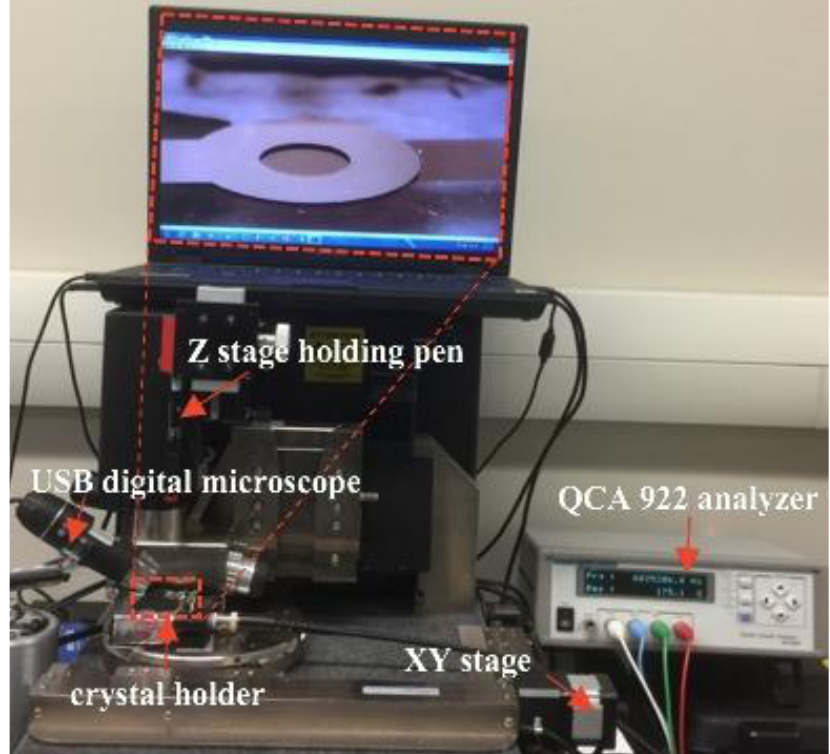
Figure 2. Picture of the actual set up used in the ink-dot study. An old, non-functional atomic force microscope was repurposed to utilize its motorized XYZ stage for accurately placing ink